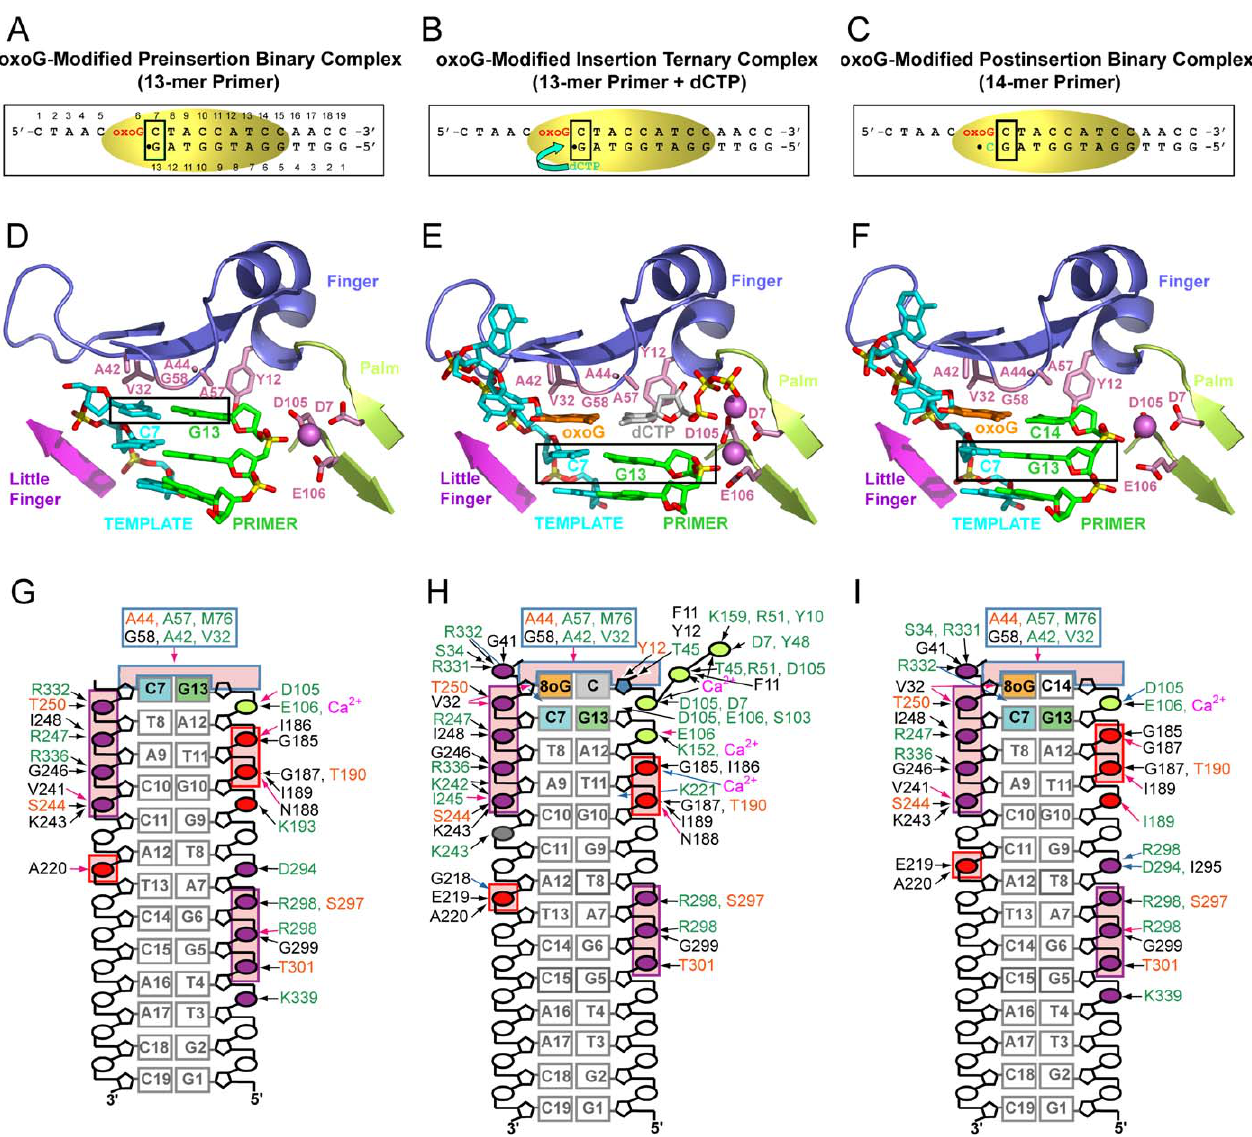
Figure 2. Structures and Intermolecular Contact Details of Dpo4 Complexes with oxoG-Modified Template-Primer DNA (A) Schematic of the pairing of the oxoG-containing 19-mer template strand with the 13-mer primer strand ending in a 2 9 ,3 9 -dideoxynucleotide in the preinsertion binary complex with Dpo4. (B) Schematic of the pairing of the oxoG-containing 19-mer template strand with the 13-mer primer strand ending in a 2 9 ,3 9 -dideoxynucleotide plus incoming dCTP in the insertion ternary complex with Dpo4. dCTP is positioned opposite oxoG. (C) Schematic of the pairing of the oxoG-containing 19-mer template strand with the 14-mer primer strand ending in a 2 9 ,3 9 -dideoxynucleotide in the postinsertion binary complex with Dpo4. Covalently incorporated C is positioned opposite oxoG. (D) Structure of the active site of the preinsertion binary complex. The DNA and protein are in stick and ribbon representations, respectively. Template residues 1–6 (including oxoG) of single-stranded overhang are disordered in the electron density maps. (E) Structure of the active site of the insertion ternary complex, with incoming dCTP paired with oxoG (anti) at the active site. (F) Structure of the active site of the postinsertion binary complex, with covalently incorporated C paired with oxoG (anti). (G) Details of the intermolecular contacts in the structure of the preinsertion binary complex. (H) Details of the intermolecular contacts in the structure of the insertion ternary complex. (I) Details of the intermolecular contacts in the structure of the postinsertion binary complex. Color-coding for panels G–I. DNA-backbone phosphate groups interacting with the palm domain are shown in light green, the phosphate groups interacting with the thumb domain within the minor groove are shown in red, and the phosphate groups interacting with the little-finger domain within the major groove are shown in purple. The conserved interactions are boxed for the thumb and little-finger contacts. Dpo4 amino acids interacting via the peptide backbone are labeled black, via their side chains, green, and via the backbone and side chains, orange. Black arrows indicate hydrogen bonding, blue arrows water-bridged contacts, and pink arrows depict van-der-Waals contacts. DOI: